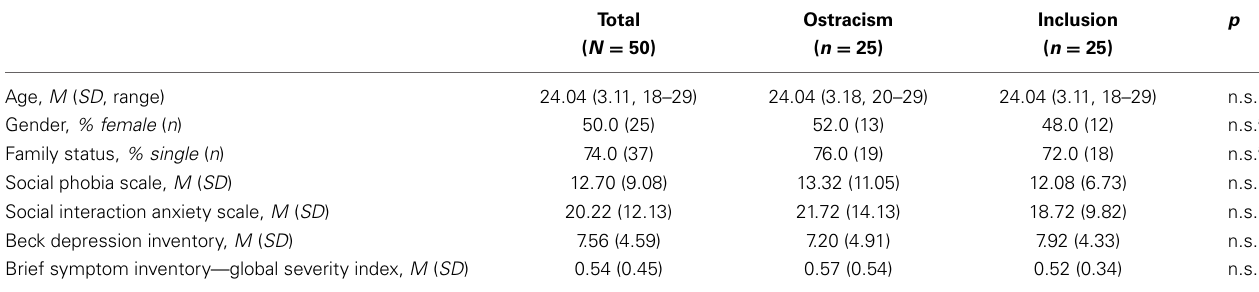
Table 1 | Subject characteristics and mean values on the assessments ( N =